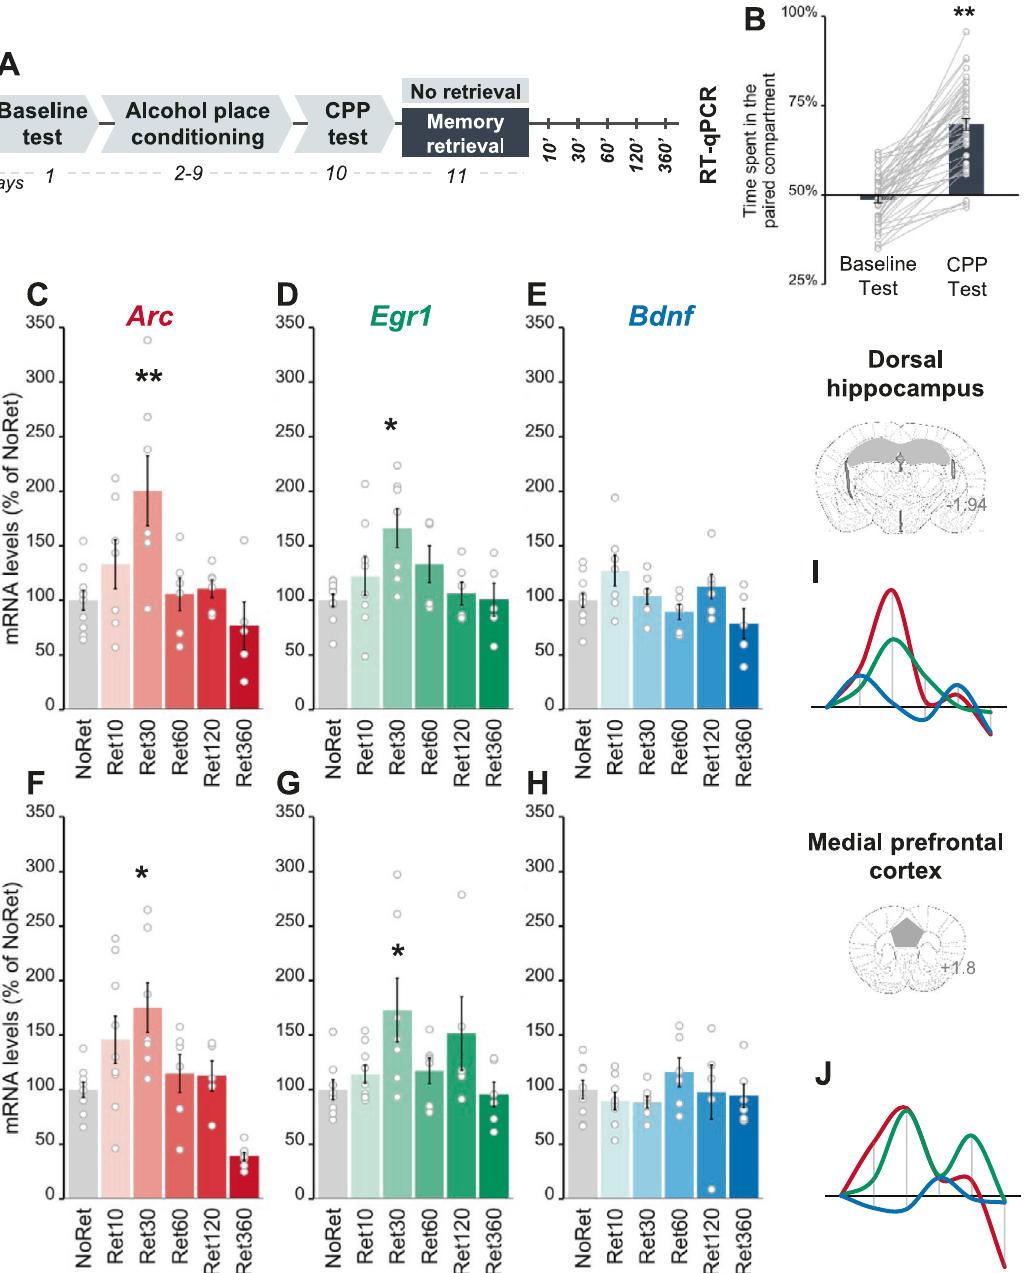
Fig. 2 Alcohol memory retrieval triggers upregulation of Arc and Egr1 but not Bdnf mRNA expression in the dorsal hippocampus and medial prefrontal cortex. A Schematic illustration of the experimental design and timeline. B Place preference scores, expressed as means ± S.E.M. of the percent of time spent in the alcohol-paired compartment (t (47) = 13.82, p < 0.0001); C – H mRNA levels, normalized to Gapdh , of the percent of change from the control group (No Retrieval). qRT-PCR analysis revealed post-retrieval alterations in gene expression (one-way MANOVA; DH: Time (F (15,86) = 2.42, p < 0.01); mPFC: Time (F (15,86) = 2.96, p < 0.001): time-dependent upregulation of mRNA levels of Arc in the DH (NoRet vs Ret30 ’ : p < 0.01) ( C ) and mPFC (NoRet vs Ret30 ’ : p < 0.05) ( F ), of Egr1 in the DH (NoRet vs Ret30 ’ : p < 0.05) ( D ) and the mPFC (NoRet vs Ret30 ’ : p < 0.05) ( G ), but not of Bdnf in the DH ( E ) or mPFC ( H ) (all p ’ s > 0.05); I , J Schematic representation of the time-dependent expression of Arc (red), Egr1 (green), and Bdnf (blue) mRNA in the DH ( I ) and mPFC ( J ). Data are expressed as means ± S.E.M. * p < 0.05; ** p < 0.01; n = 9 – 6 per